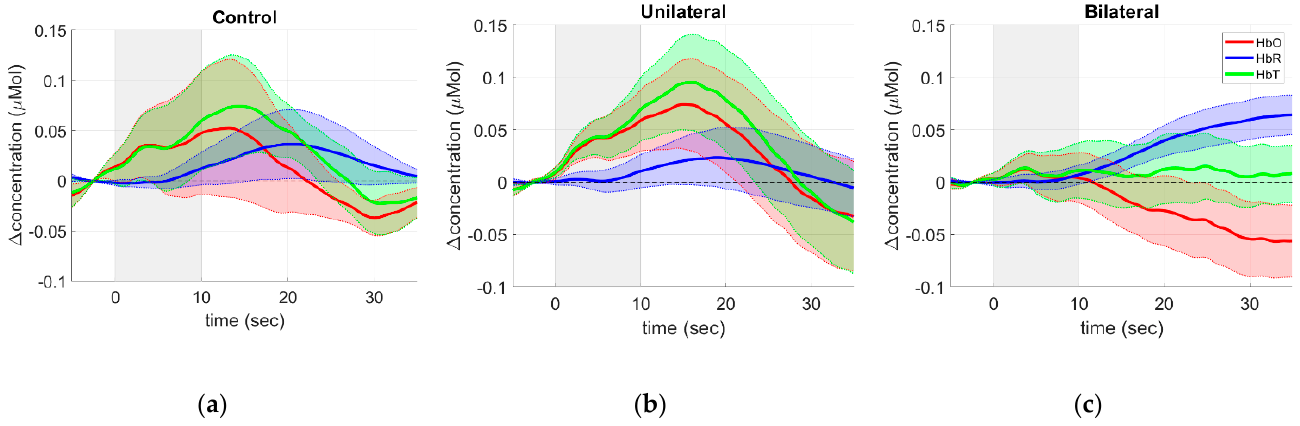
Figure 3. Group averaged time-courses of the oxy − hemoglobin (HbO, red), deoxy − hemoglobin (HbR, blue), and total hemoglobin (HbT, green) concentration changes due to the breath-holding task performed by ( a ) control, ( b ) unilateral, and ( c ) bilateral groups. The solid curves represent the median values across all subjects in each group, while the shadows around the curves represent the standard error of the mean. The gray shadow in the plots represents the task duration.